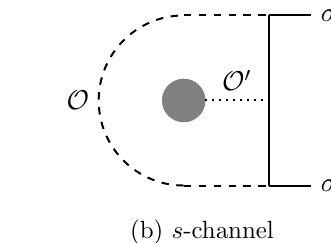
Figure 9. The t -channel diagram denotes a sum over the asymptotics (cid:14) ( O )